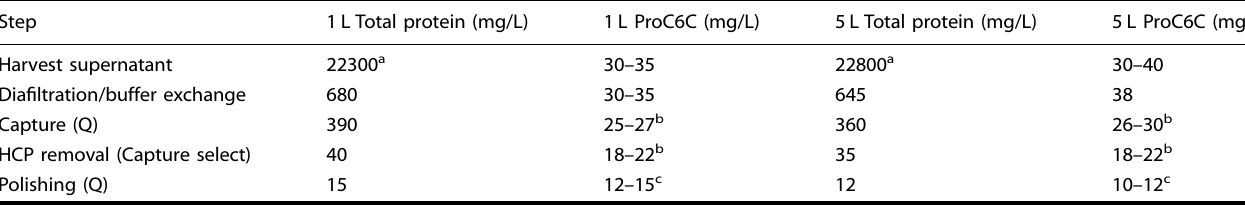
Table 1. Mass Balance summary of